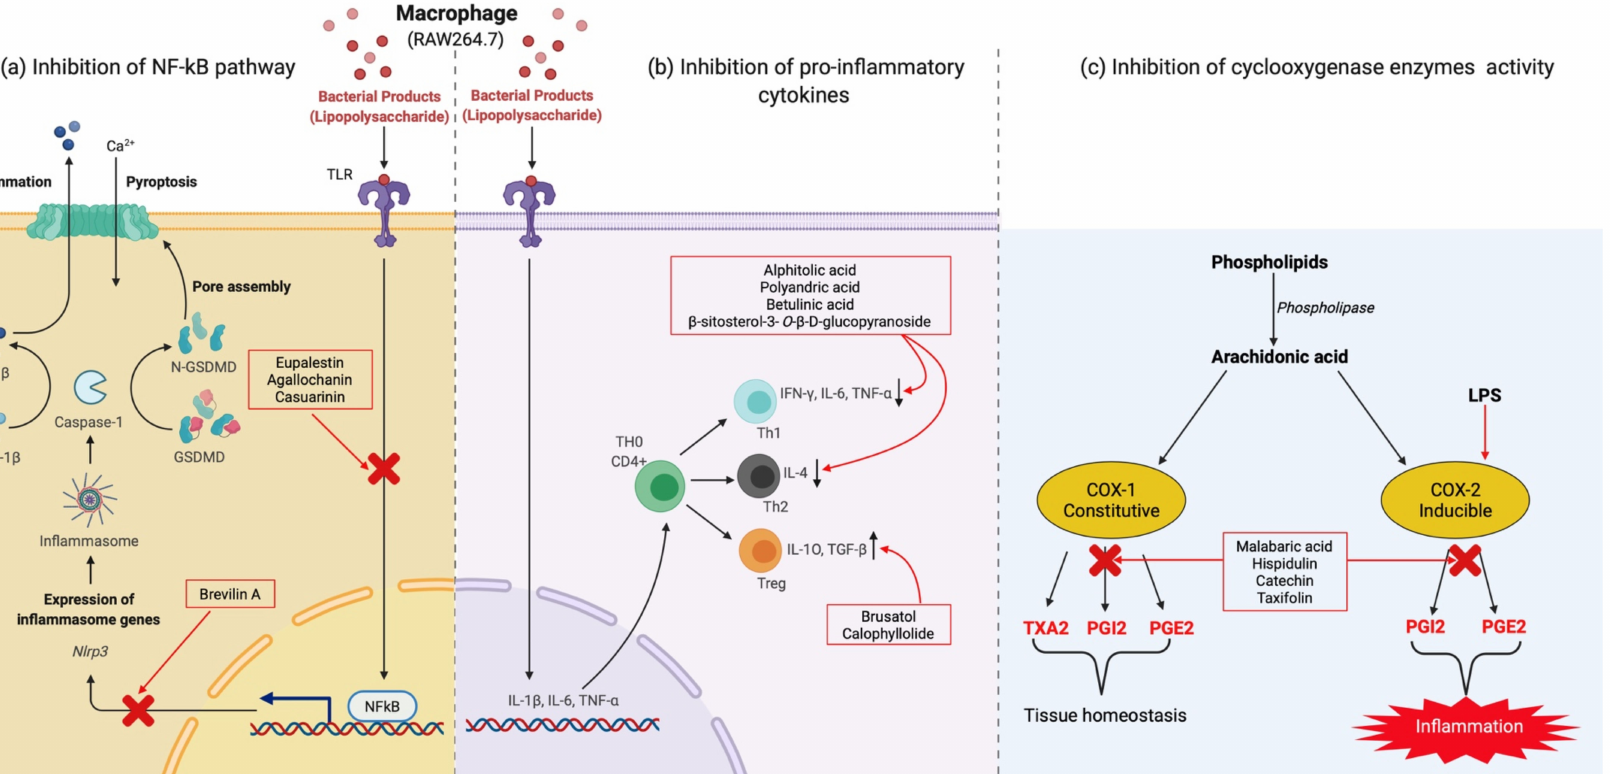
Figure 4. Three major mechanisms of anti-inflammatory activities shown by compounds isolated from medicinal plants of Tropical Australia: ( a ) inhibition of NF- κ B pathway; ( b ) inhibition of various pro-inflammatory cytokines; ( c ) inhibition of cyclooxygenase enzymes (COX-1 and COX-2) activities. Abbreviations: COX (COX-1 and 2), cyclooxygenase 1 and 2; IL, interleukins; GSDMD, Gasdermin-D; LPS, lipopolysaccharide; NF- κ B, nuclear factor kappa B; Nlrp3, NOD-, LRR- and pyrin domain-containing protein 3; PG, prostaglandins (PGI2, PGE2); Th cells, T-helper cells (Th1, 2); Th0, naïve T helper cells; Treg, regulatory T helper cells; TX, thromboxane (TXA2); TGF, transforming growth factor (TGF- β ); TNF, tumour necrosis factor (TNF- α ); TLR, toll-like receptor. Courtesy : Figure is adapted from Simon [258] and McDaniel et al. [259], and modified with web-based tool